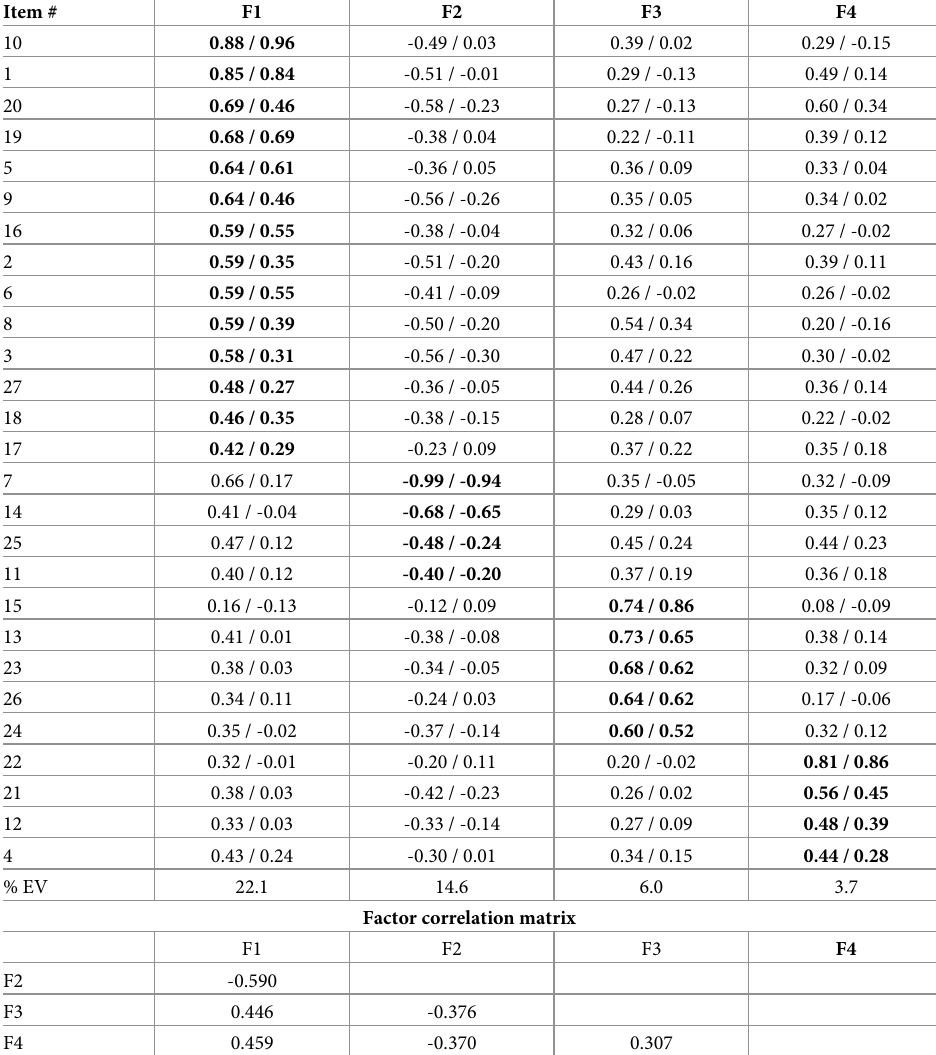
Table 3. Results of EFA—The structure / pattern matrix and the factor correlation